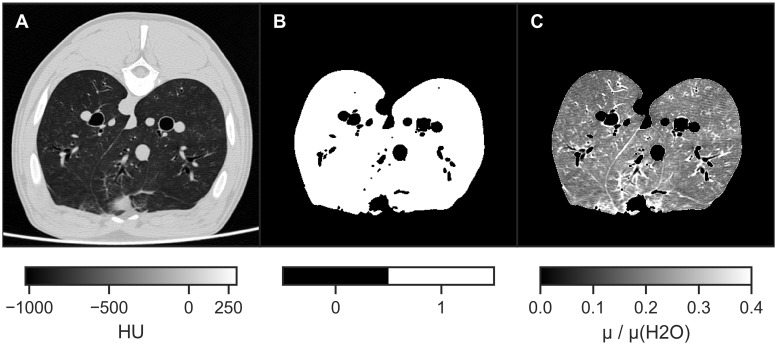
CT slice and lung segmentation / masking (animal 2).(A) Slice from reconstruction of one of the CT scans (20 mbar). (B) Segmentation S of the lung via thresholding and binary closing as defined in Eq (7). Interior of bronchi and more strongly attenuating tissues (HU ≈ 0) are excluded. (C) Masked volume of relative attenuation values M, as defined in Eq (9).